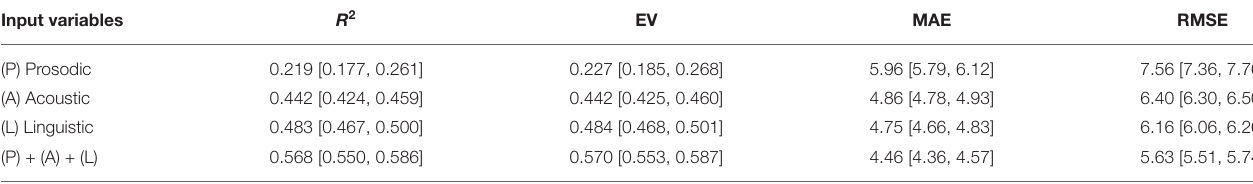
TABLE 2 | Regression model performance of speech features predicting loneliness scores resulting from 20 iterations of 10-fold cross validation.